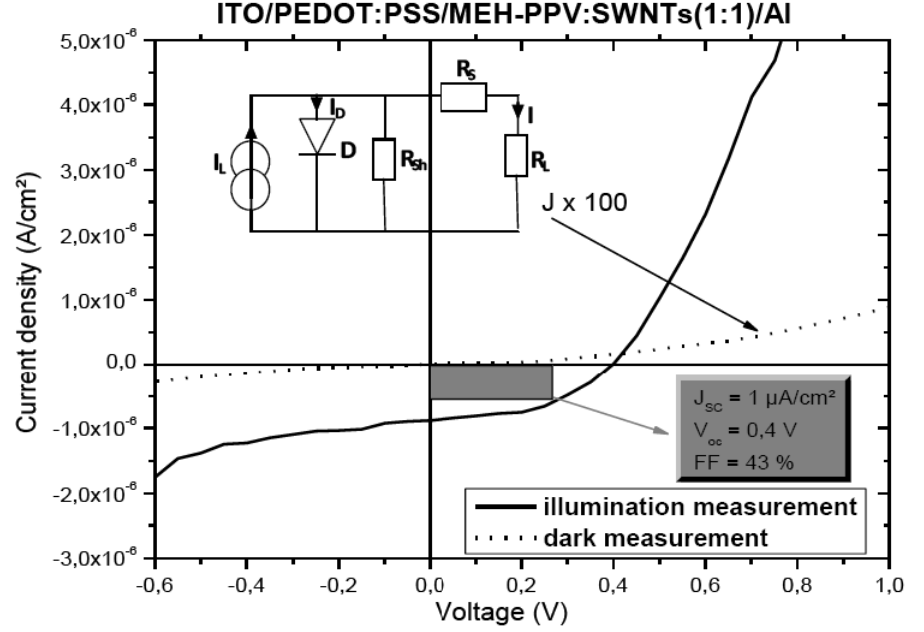
Figure 3. Current density-voltage characteristics of ITO/PEDOT:PSS/MEH- PPV:SWNTs(1:1)/Al cells in the dark (x 100 for more readability) and under